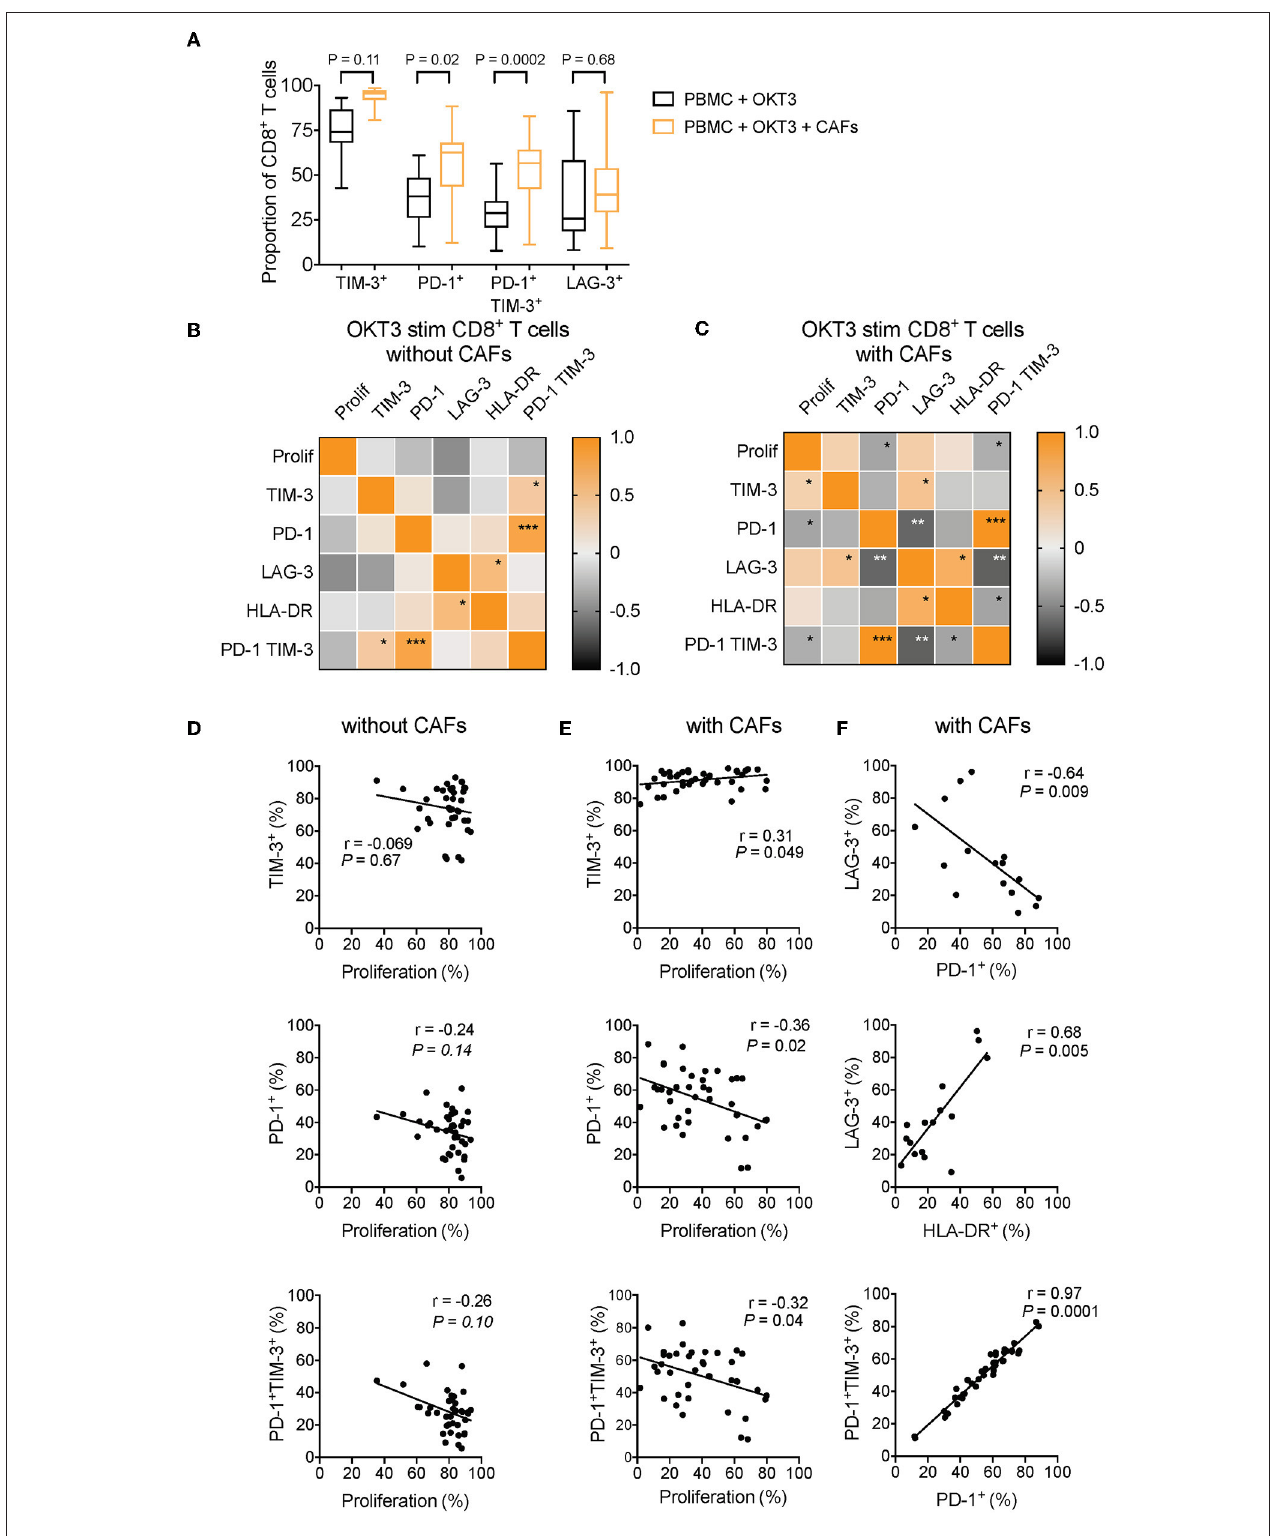
FIGURE 7 | CAF-induced expression of PD-1 is negatively associated to CD8 + T-cell proliferation. (A) Multiple comparison test between expression of different co-inhibitory markers on CD8 + T-cells in the absence (black) or presence (orange) of CAFs after OKT3 stimulation ( n = 40 for TIM-3 and PD-1, and n = 16 for